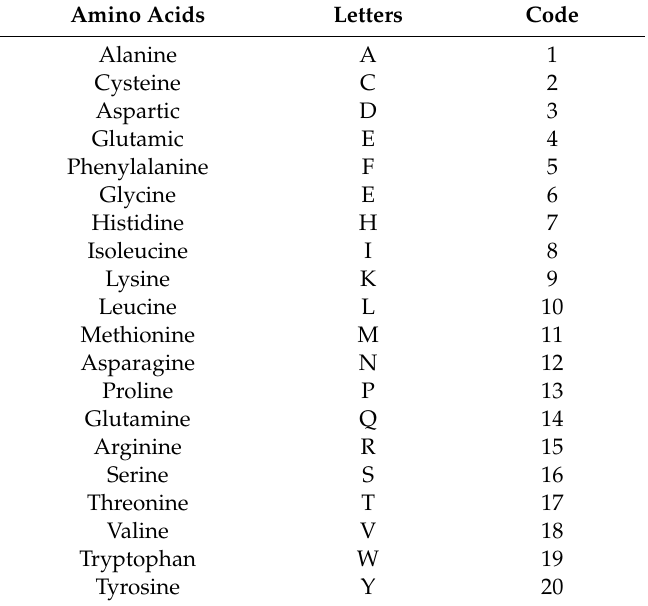
Table 1. Symbolic representation of each Amino Acids and its code. Amino Acids Letters